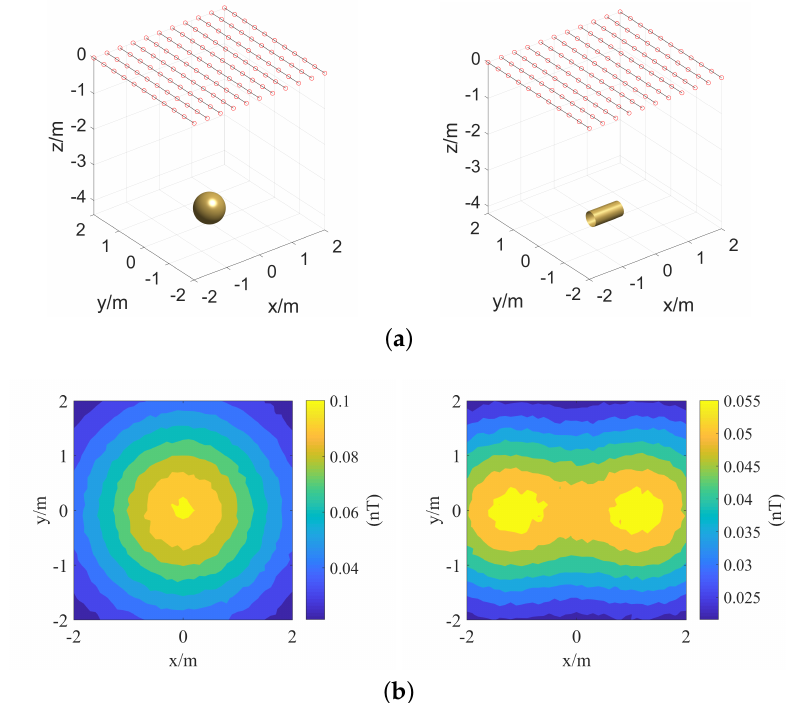
Figure 4. Secondary field spatial response of spherical and cylindrical objects. ( a ) shows detection scenes, and the red lines and small circles denote the track of the detector; ( b ) shows the secondary field strength map of ( a